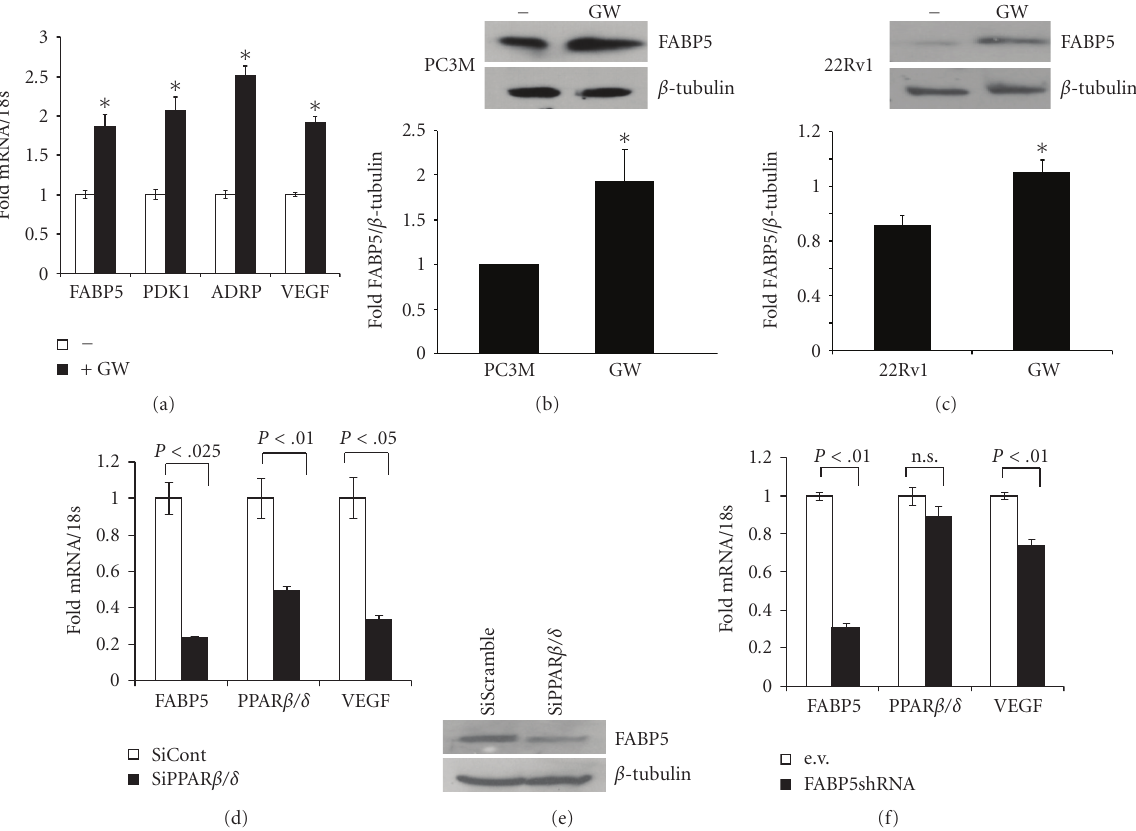
Figure 2: Activation of PPAR β/δ results in upregulation of FABP5. (a) PC3M cells were treated with GW0742 (1 μ M, 4 h). Expression of FABP5, PDK1, ADRP, and VEGF were assessed by Q-PCR. The data were normalized to the untreated control. (b, c) Denoted cells were treated with 1 μ M (a) or 2 μ M (b) GW0742 for 16 h. Left panels, immunoblots of FABP5 in untreated versus GW0742-treated cells. Right panel: Densitometry analyses depicting changes in FABP5 expression upon treatment with GW0742 in three independent experiments (mean ± S.D.). (d, e) PC3M cells were transfected with vectors harboring SiScramble or PPAR β/δ siRNA. Three days later, expression of FABP5, PPAR β/δ , and VEGF mRNA in were measured by Q-PCR (d) and FABP5 expression was assessed by immunoblot (e). (f) PC3M cells were stably transfected with an empty vector (PGIPZ), or a vector harbouring shFABP5. Expression levels of FABP5, PPAR β/δ , and VEGF mRNA were measured by Q-PCR. ∗ P < . 05 versus nontreated